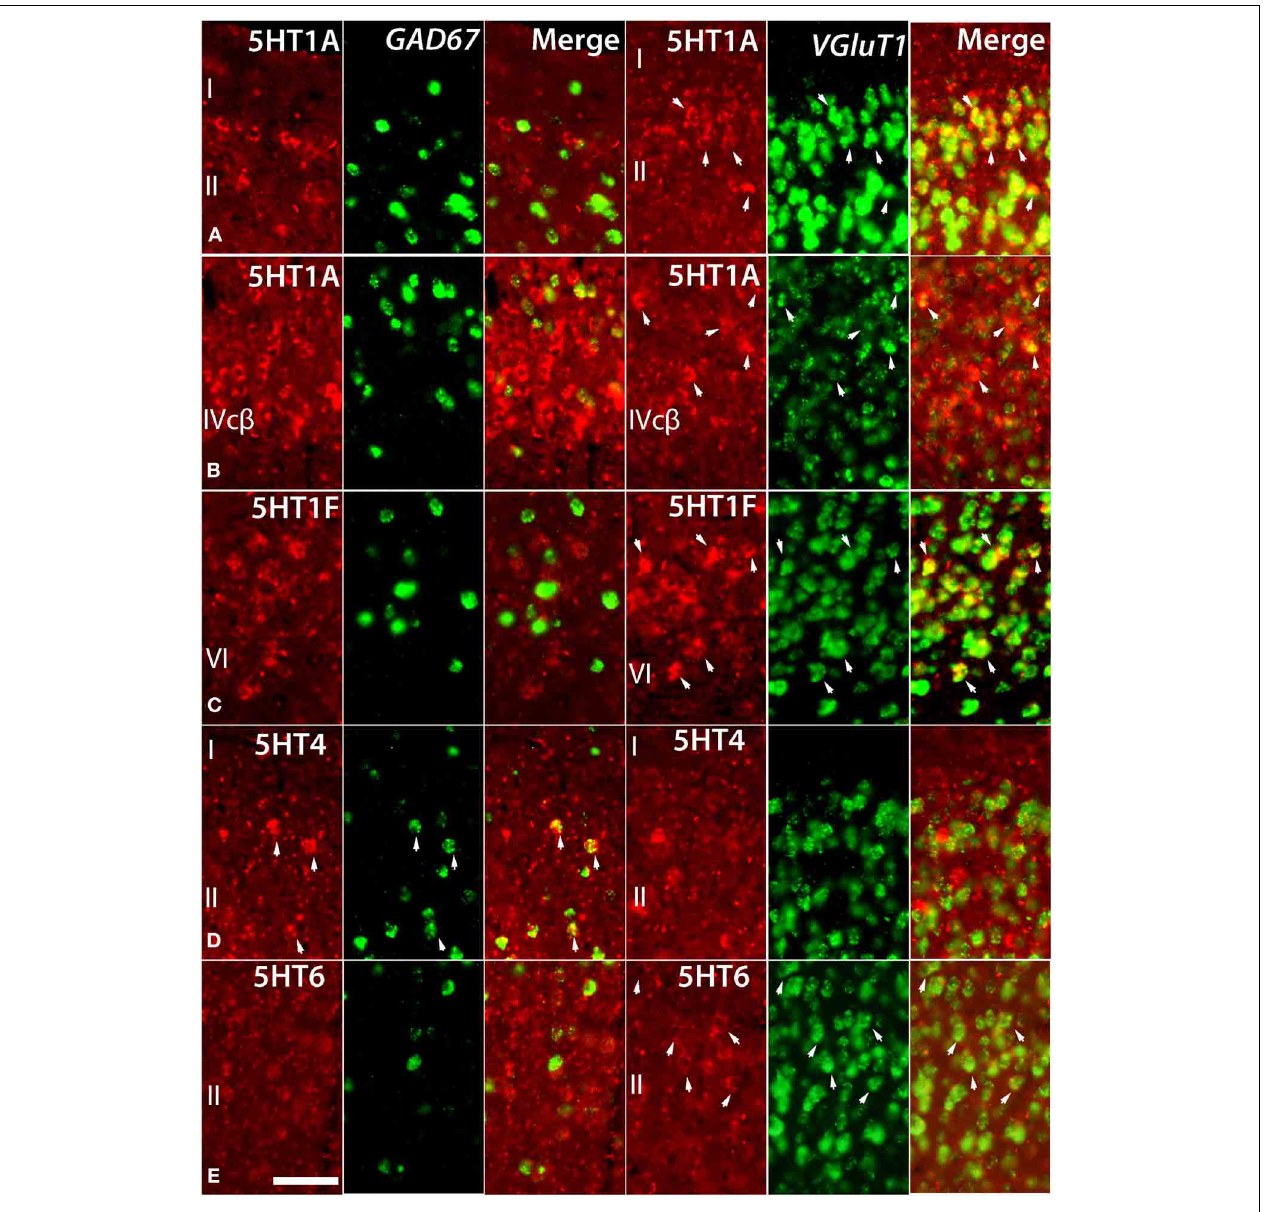
FIGURE 4 | Double ISH of 5HTR s (red, DIG) with GAD67 and VgluT1 neuronalmarkers(green,FITC). 5HT1A, 5HT1F , 5HT4 ,and 5HT6 with GAD67 and VgluT1 neuronal markers in marmoset V1. 5HT1A in layers II (A) and IVc β (B) , 5HT6 in layer II (E) , and 5HT1F in layer VI (C) were not expressed in